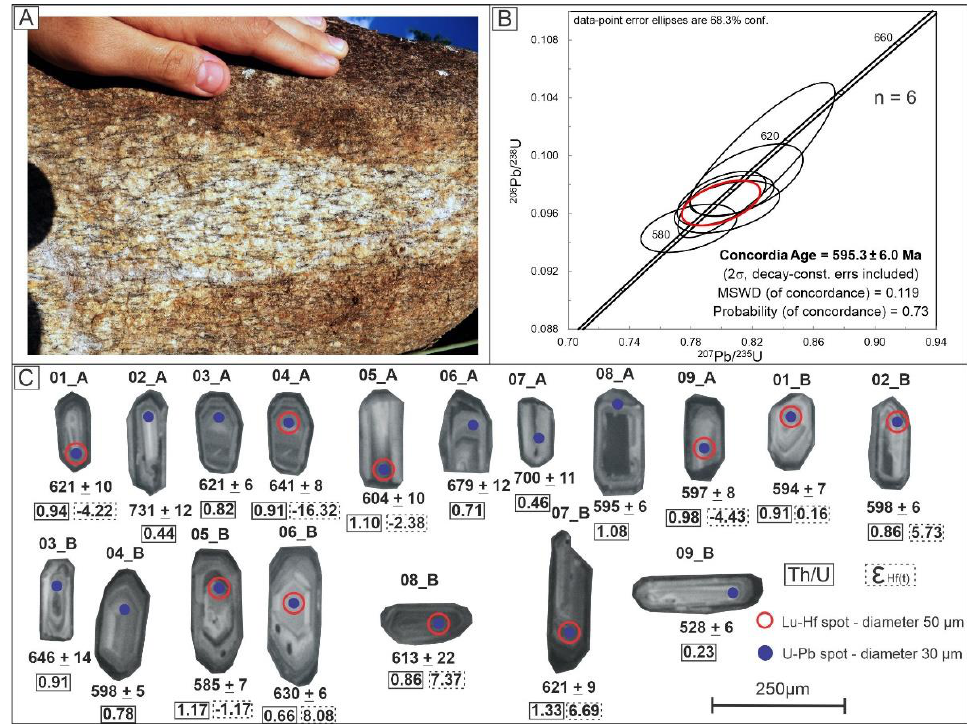
Figure 4. ( A ) Representative sample of Muniz Freire orthogneiss from the point SAIC-13. ( B ) Concord age for the sample SAIC-13. ( C ) Cathodoluminescence image of the analyzed zircon grains.